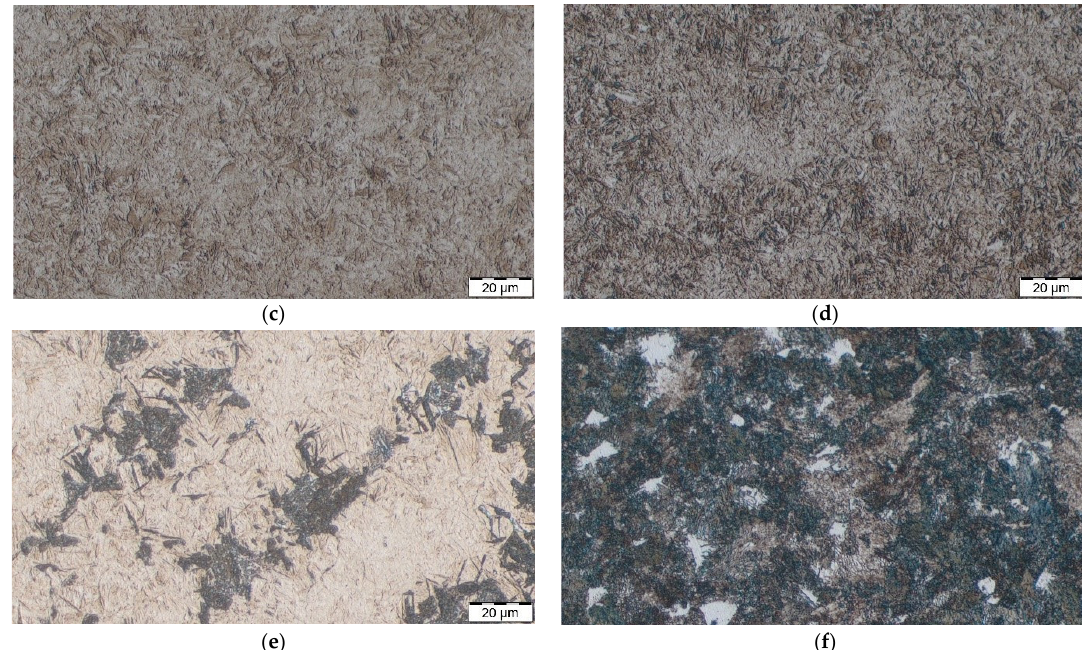
Figure 7. Optical micrographs of 52CrMoV4 cooled at ( a ) 100 °C/s, ( b ) 30 °C/s, ( c ) 20 °C/s, ( d ) 10 °C/s, ( e ) 1 °C/s, and ( f ) 0.1 °C/s.